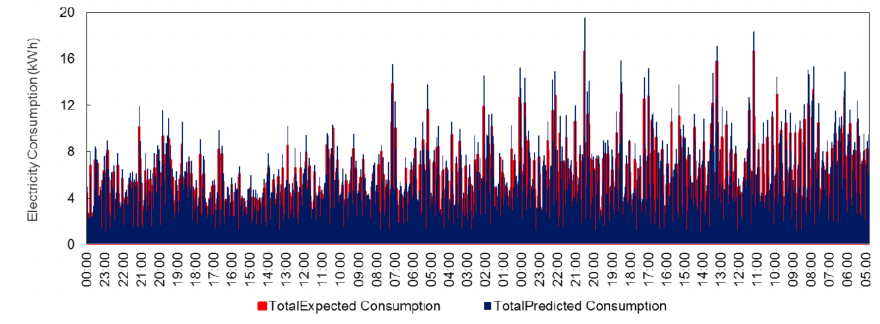
Figure 12. Comparison between the results of the aggregated actual and the aggregated predicted electricity demand for the testing